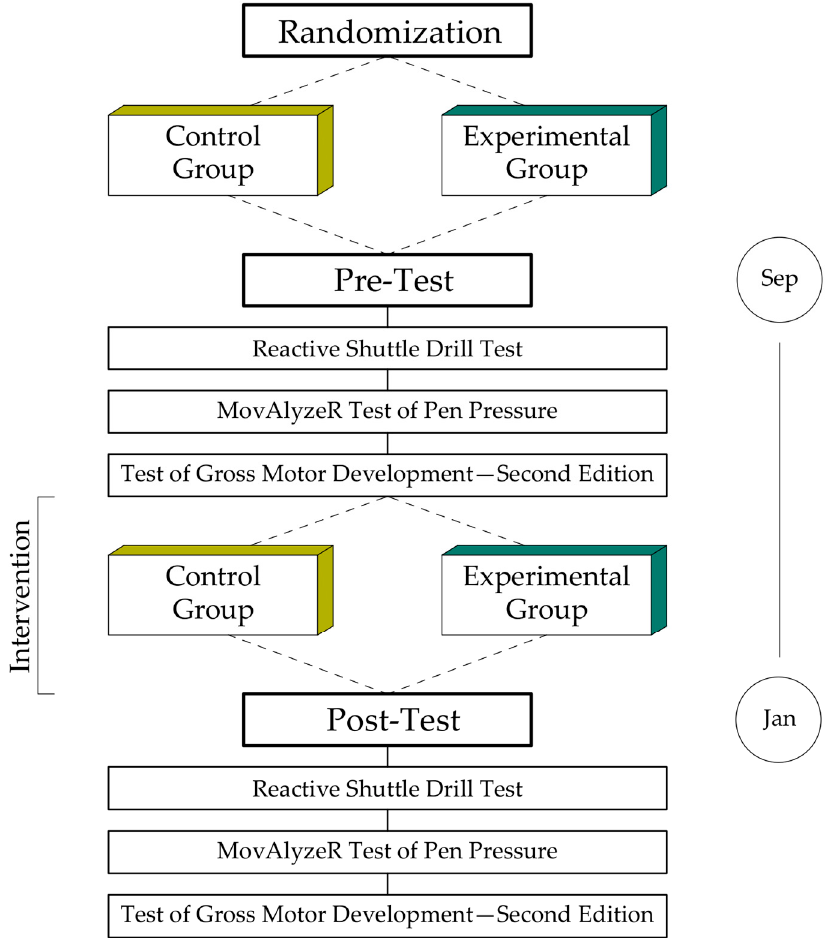
Figure 2. The experimental workflow. Classes were randomly assigned into control (no-Eduball) and experimental (Eduball) groups. Before and after the one-semester intervention, participants were tested in space-time orientation using the Reactive Shuttle Drill test, in graphomotor dexterities through the MovAlyzeR pen pressure test, and in fundamental movement (locomotor and object control) skills via the Test of Gross Motor Development (edition #2). The order of the tests was identical for each student and at each stage of the experiment.